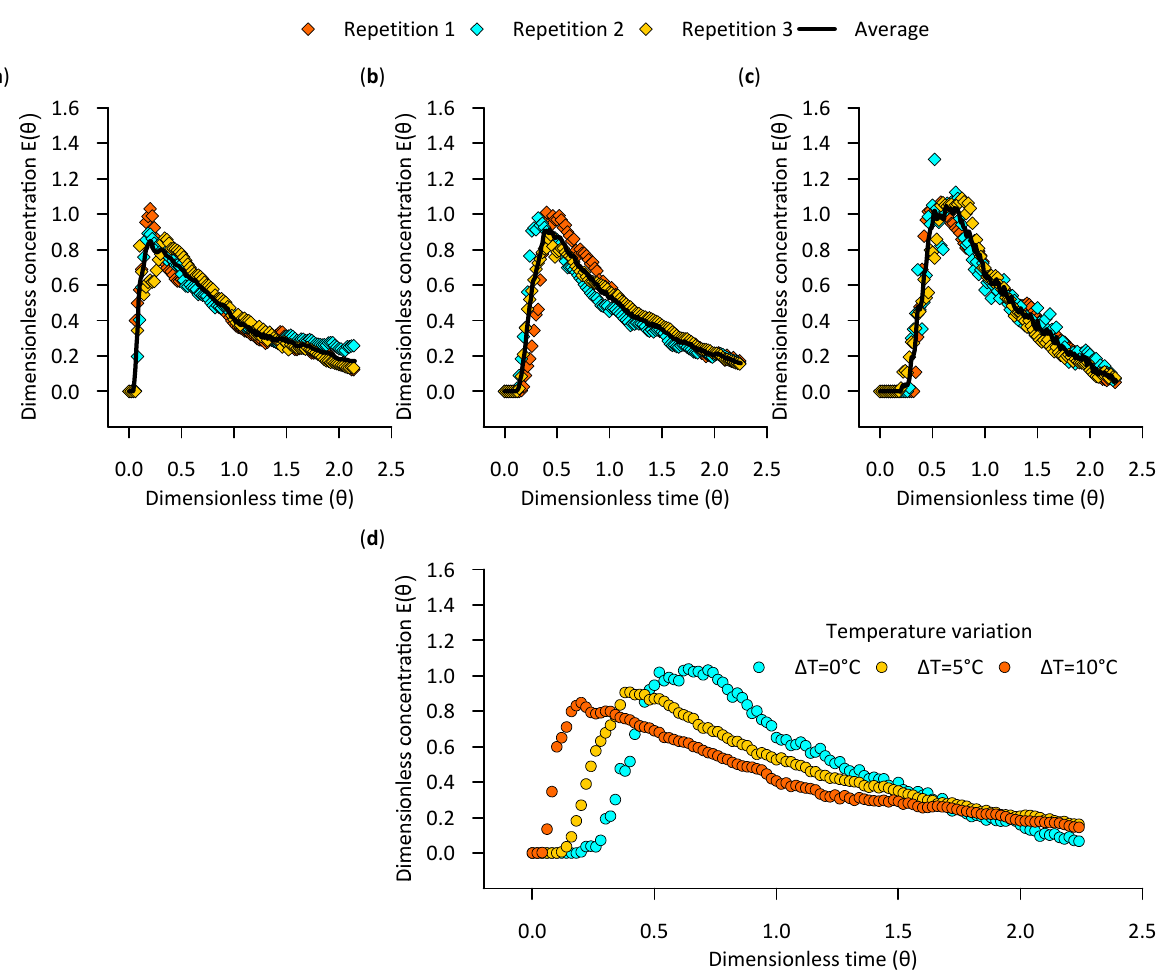
Figure 6. Effect of temperature variation in RTD characterization: ( a ) 10 °C variation, ( b ) 5 °C variation, ( c ) 0 °C variation, ( d ) Comparison of averaged results.